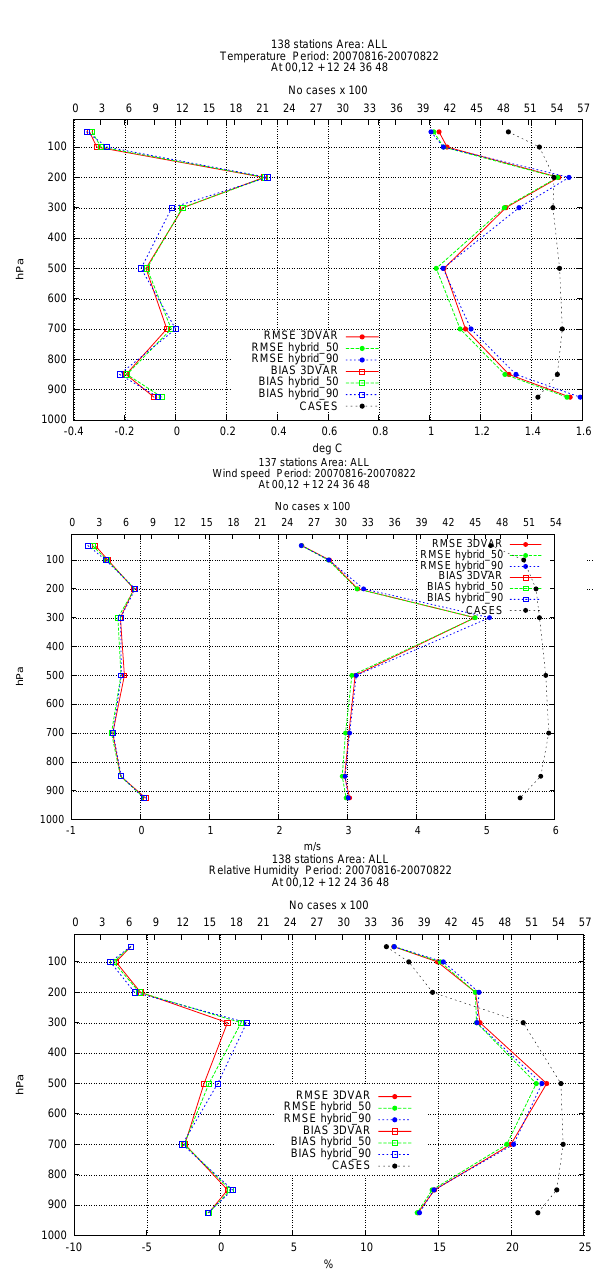
Fig. 7. Bias and RMS (Root Mean Square) verification scores for temperature (upper), wind speed (middle) and relative humidity (bottom) forecast profiles as verified against radiosonde observa- tions averaged over the period 16 - 22 August 2007 and over +12h, +24h, +36h and +48h forecasts. Experiments 3DVAR (3D-Var, red curves), hybrid 90 (10% 3D-Var and 90% ensemble covariance, blue curves) and hybrid 50 (50% 3D-Var and 50% ensemble co- variance, green curves). The curve marked CASES indicates the number of observed values for the verification.